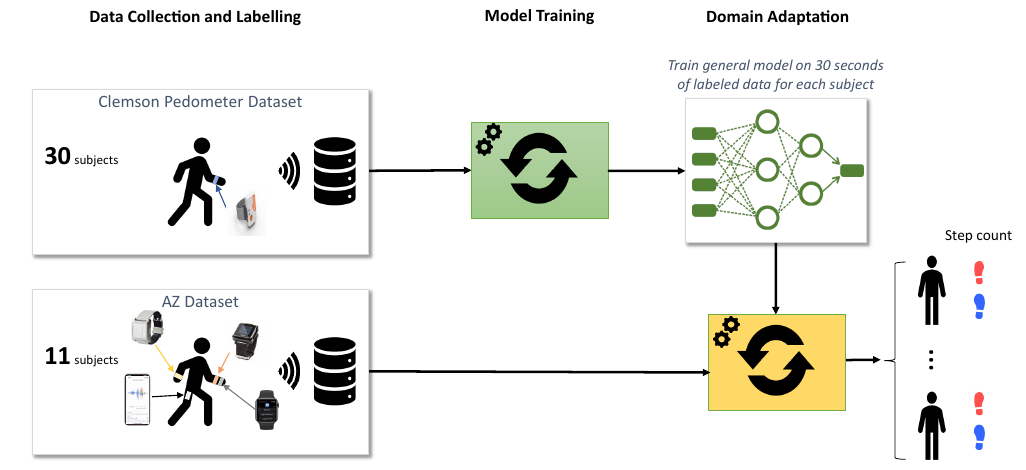
Figure 5. Personalized transfer learning on test data.